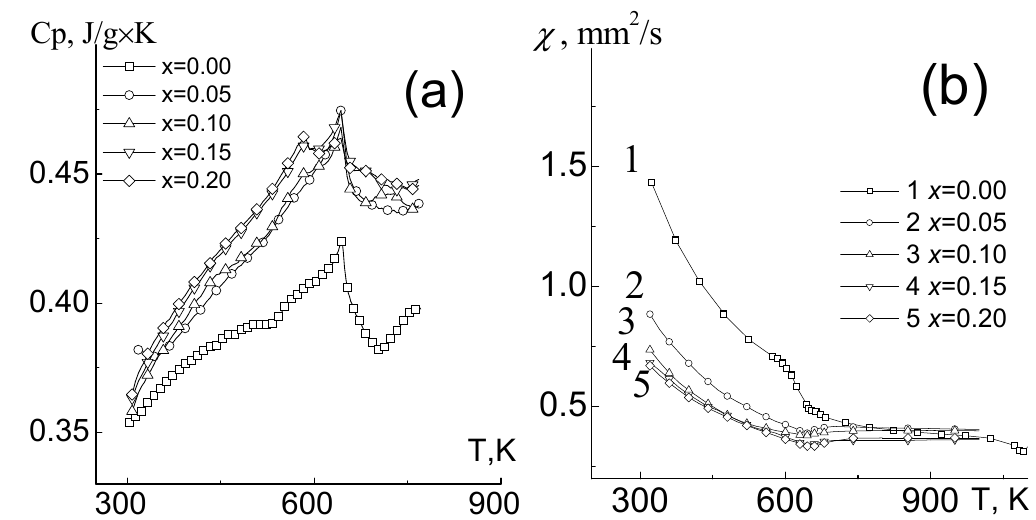
Figure 5. Temperature dependencies of the specific heat, C p , ( a ) and thermal diffusivity, χ , ( b ) of studied Bi 1 − x Er x FeO 3 ceramic samples.